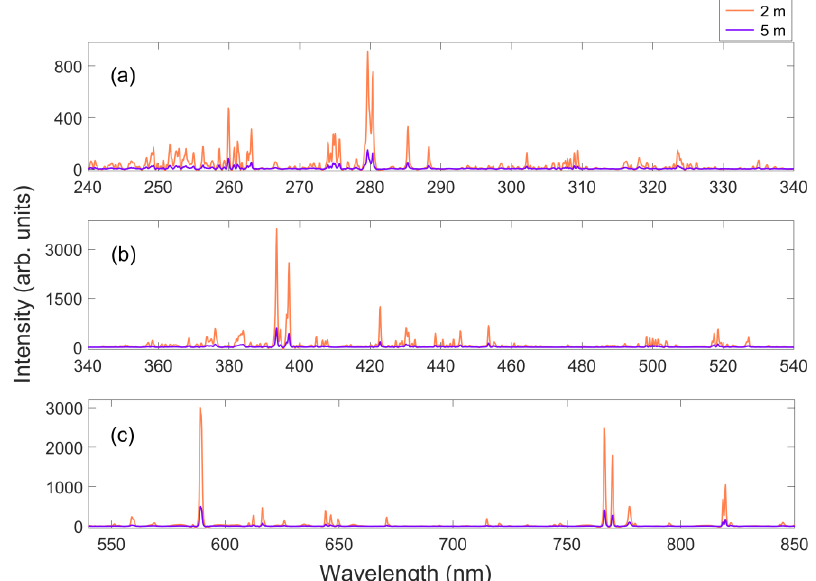
Figure 10. The LIBS spectra collected from the basalt reference sample at the two distances, in the ordinary laboratory environment. The orange lines denote the result for 2 m and the purple lines for 5 m. ( a ) The spectra in Channel 1. ( b ) The spectra in Channel 2. ( c ) The spectra in Channel 3.